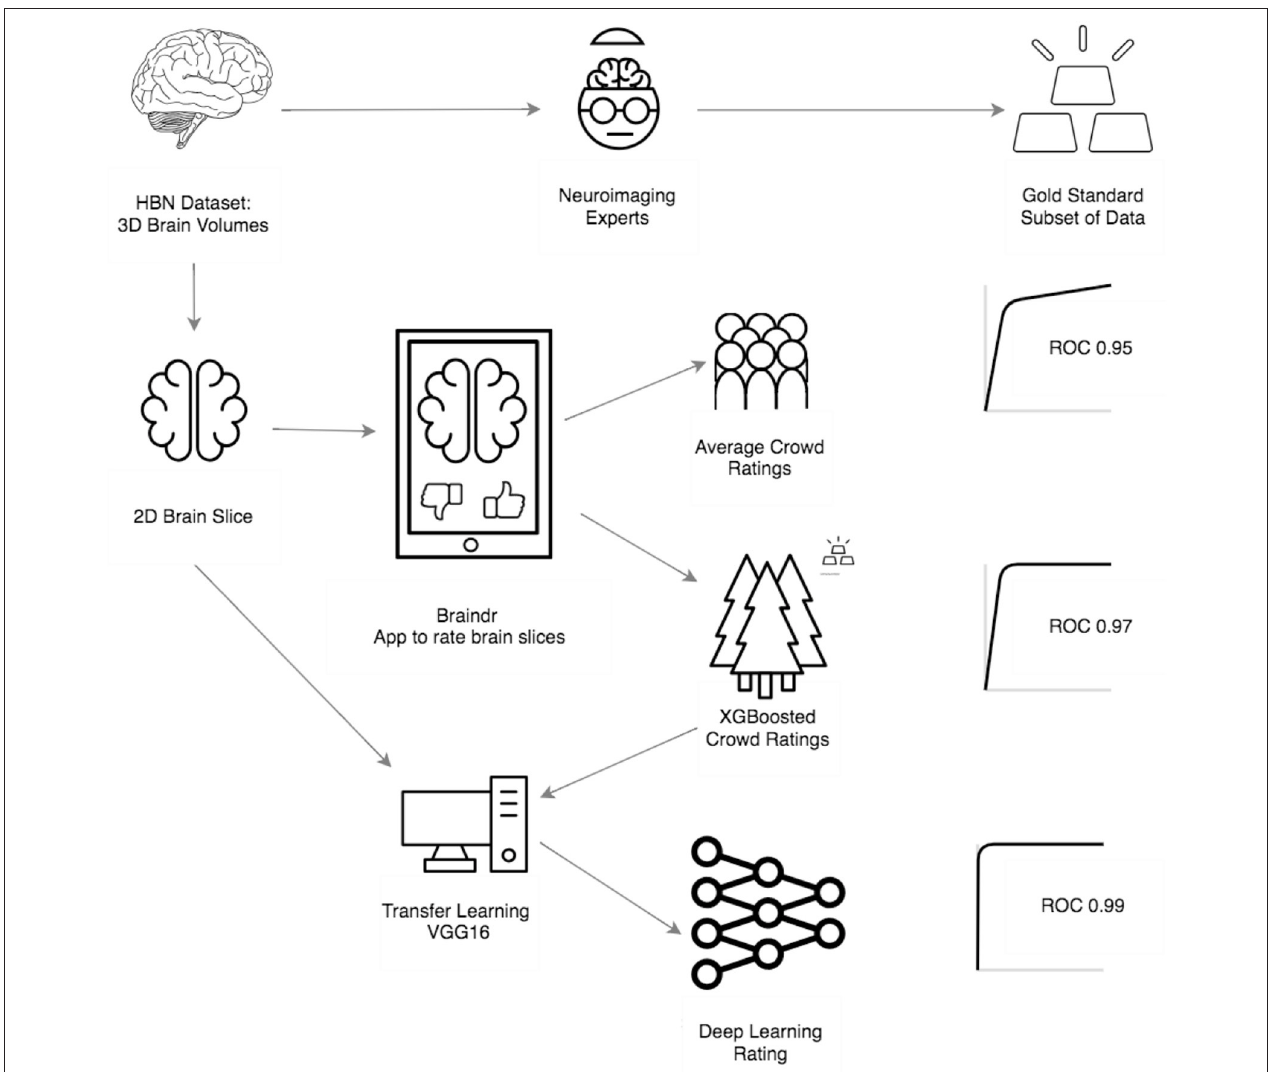
FIGURE 1 | Overview and results of our procedure: First, the HBN data set was rated by 4 neuroimaging experts to create a gold standard subset of data. Next, the 3D MRI scans were converted into 2D axial brain slices, which were loaded onto braindr (https://braindr.us), a web application to crowdsource the quality ratings (see Methods). Area under the curve of a the Receiver Operating Characteristic curve (AUC) was calculated for the average citizen scientist quality rating for each slice. Compared to an expert-labeled test set, this resulted in an AUC of 0.95. In an effort to remove inaccurate citizen scientists, the ratings were aggregated by fitting a model that weights each citizen scientist contribution to the slice score by how much that individual’s scores match those of the experts. The resulting AUC was 0.97. Finally, the 2D brain slices together with the weighted citizen scientist ratings were used to train a neural network. In an ROC analysis on left out data, the AUC of these predictions was